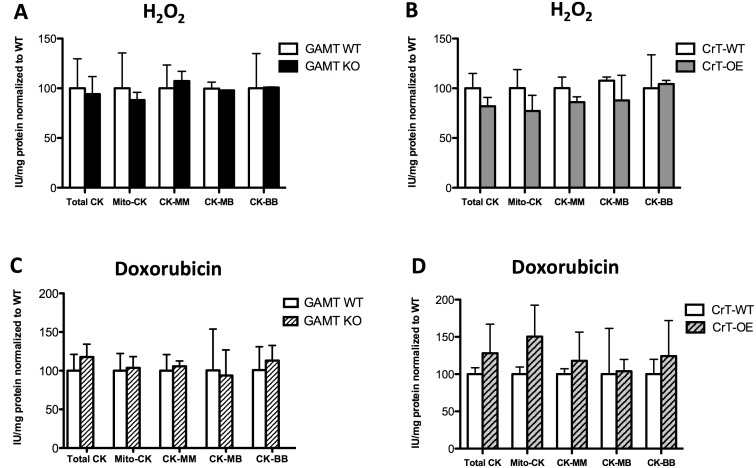
Effect of acute oxidative stress on myocardial creatine kinase (CK) isoform activities: mitochondrial (Mito-CK), myofibrilar (CK-MM), minor cytosolic isoforms (CK-MB, CK-BB): Effect of 0.5 µM H2O2 on CK isoenzyme activities of (A) GAMT WT (n = 3) and KO (n = 6) (B) CrT-WT (n = 3) and OE (n = 4).Effect of doxorubicin on CK isoenzyme activities of (C) GAMT WT (n = 6) and KO (n = 7) and (D) CrT-WT (n = 4) and OE (n = 5). Enzyme activities given in IU/mg protein normalized to WT values. Data mean±S.E.M. Comparison with wild-type for that strain by Student’s t-test.